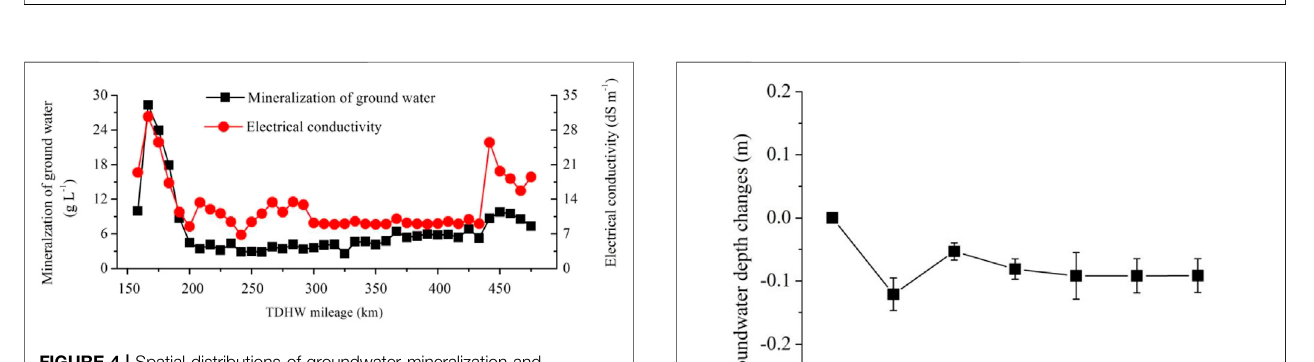
FIGURE 3 | Comparison of the protecting effects of the shelterbelt for the Taklamakan Desert Highway and Taklamakan Desert Botanic Garden, the vertical sand barrier,andstrawcheckerboardsin1994 (A) ;theshelterbelthasbeenbuiltin2008 (B) ,beforetheTaklamakanDesertBotanicGarden hasbeenestablished in1995 (C) and after in 2006 (D) .